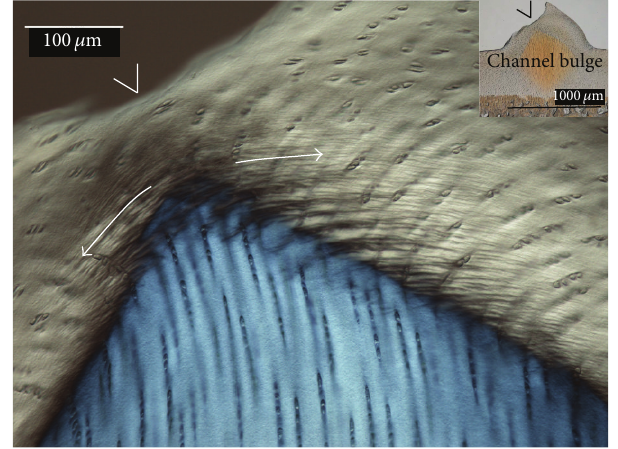
Figure 11: Bulge facture of a Cr7 sample. Following 7 MPa creep loading, samples suffered microfractures in the surface layer of the bulge region, as shown here. The arrows trace the fibrillar in-phase crimping in the surface layer and the “V” indicates the crack path. DIC